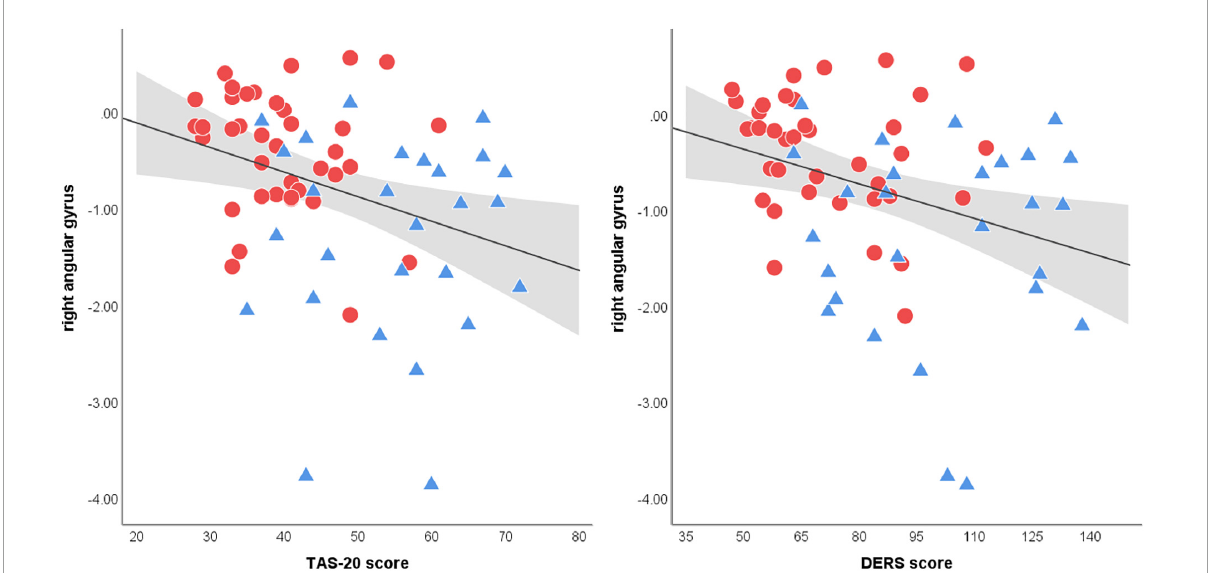
FIGURE3 Scatter plots of the correlation between right angular gyrus activation during affective ToM processing and clinical measures. Both Toronto Alexithymia Scale (TAS-20) and Difficulties in Emotion Regulation Scale (55) scores shows significant correlations with angular gyrus activations (spearman’s r = − 0.37. p = 0.002; spearman’s r = − 0.37. p = 0.003, respectively). The linear trend-line is demonstrated in black and the area colored in gray represents 95% confidence intervals of mean scores (red circle = NSSI group, blue triangle = control